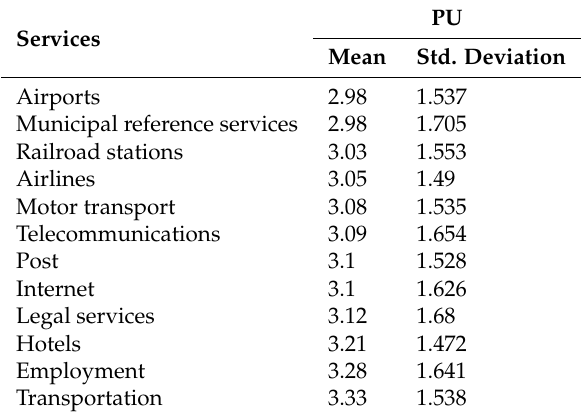
Table A11. Ranking for information about services by mean score of